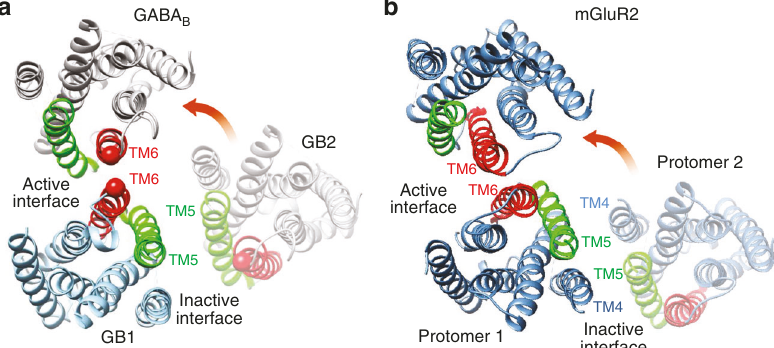
Fig. 5 Rearrangement of the transmembrane domain interface during GABA B heterodimer activation 3D model of the GB1-GB2 7TM heterodimer ( a ) and mGluR2 7TM homodimer ( b ) in the resting and active orientations. Based on these models, the amplitude of the relative reorientation of two 7TMs in the dimer might be smaller in the GABA B receptor than in